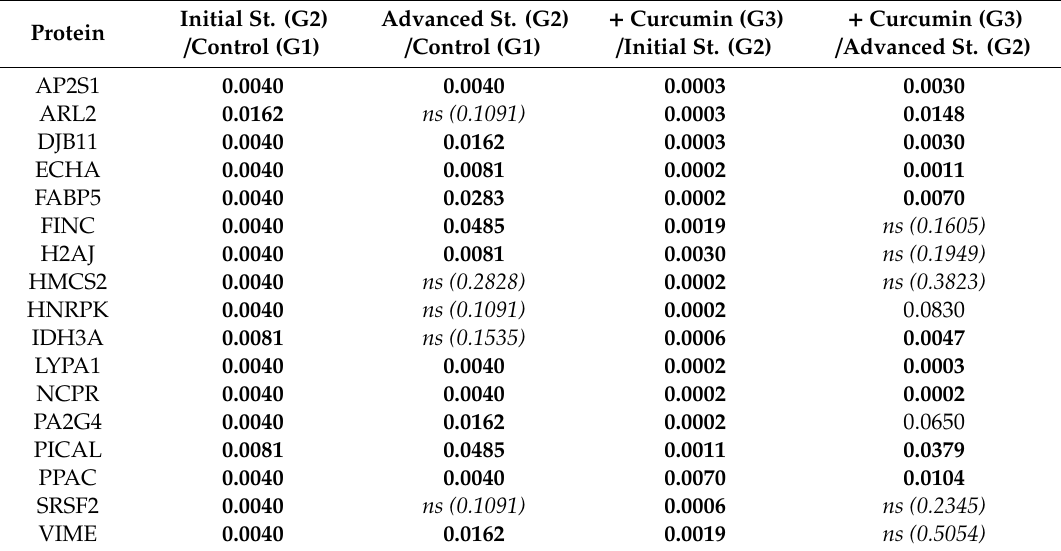
Table 2. Statistical analysis of di ff erential protein abundance between